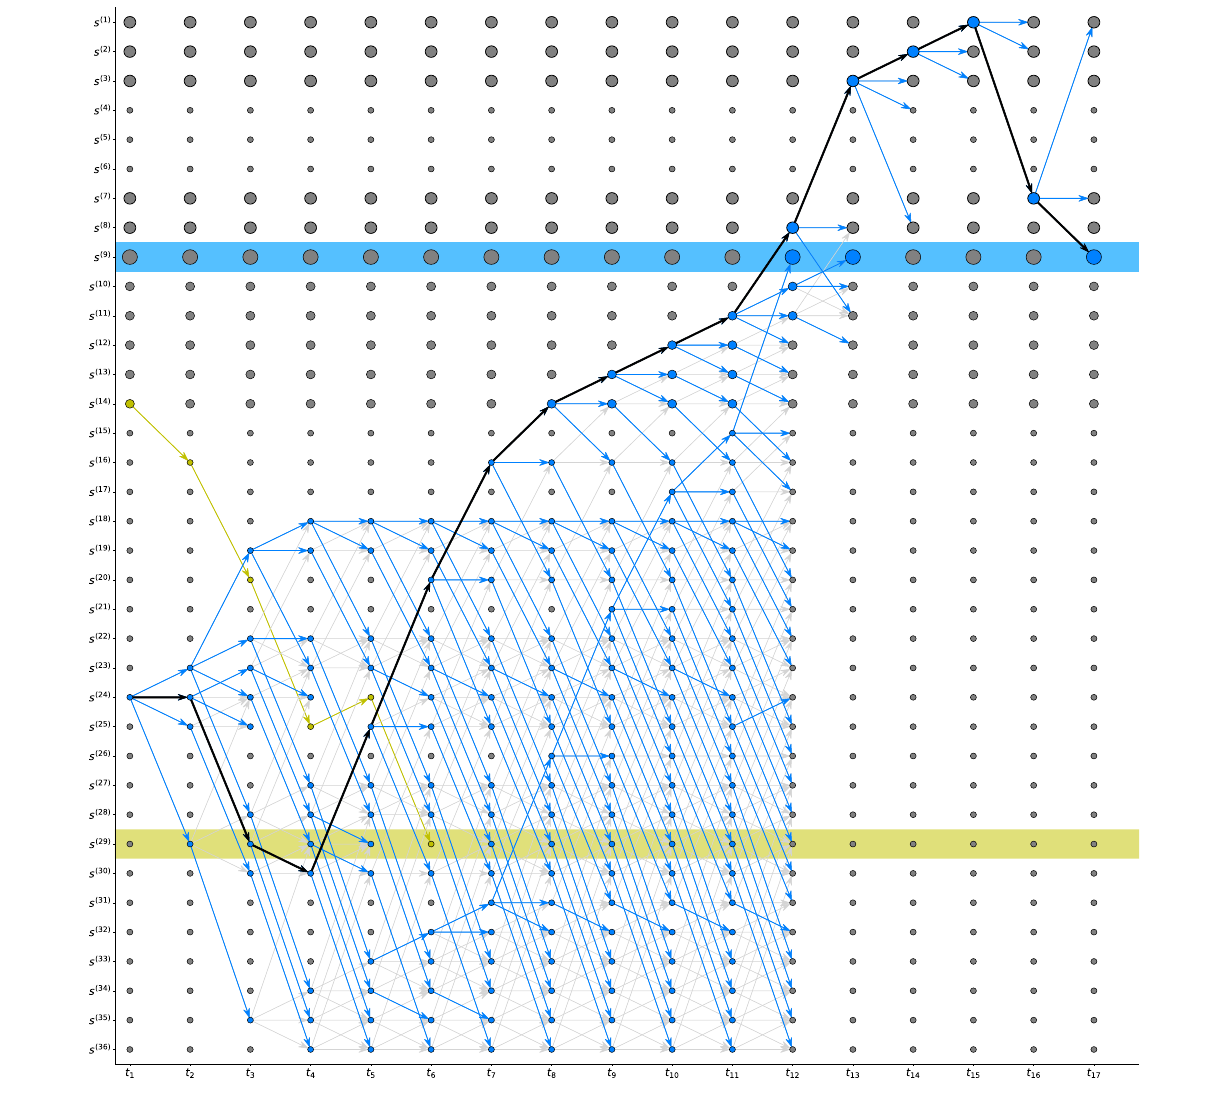
FIGURE 4 | Trellis related to the analysis of the optimal path for the blue agent based on the preliminary presence of the yellow agent. The highest reward map statesarerepresentedbylargercircles.Thebluearrowsrepresenttheforwardpropagatedprojections,whilethelightgrayonesdenotetheotherdiscardedpossibilities. The optimal path determined by forward propagation within the FGrn is represented in